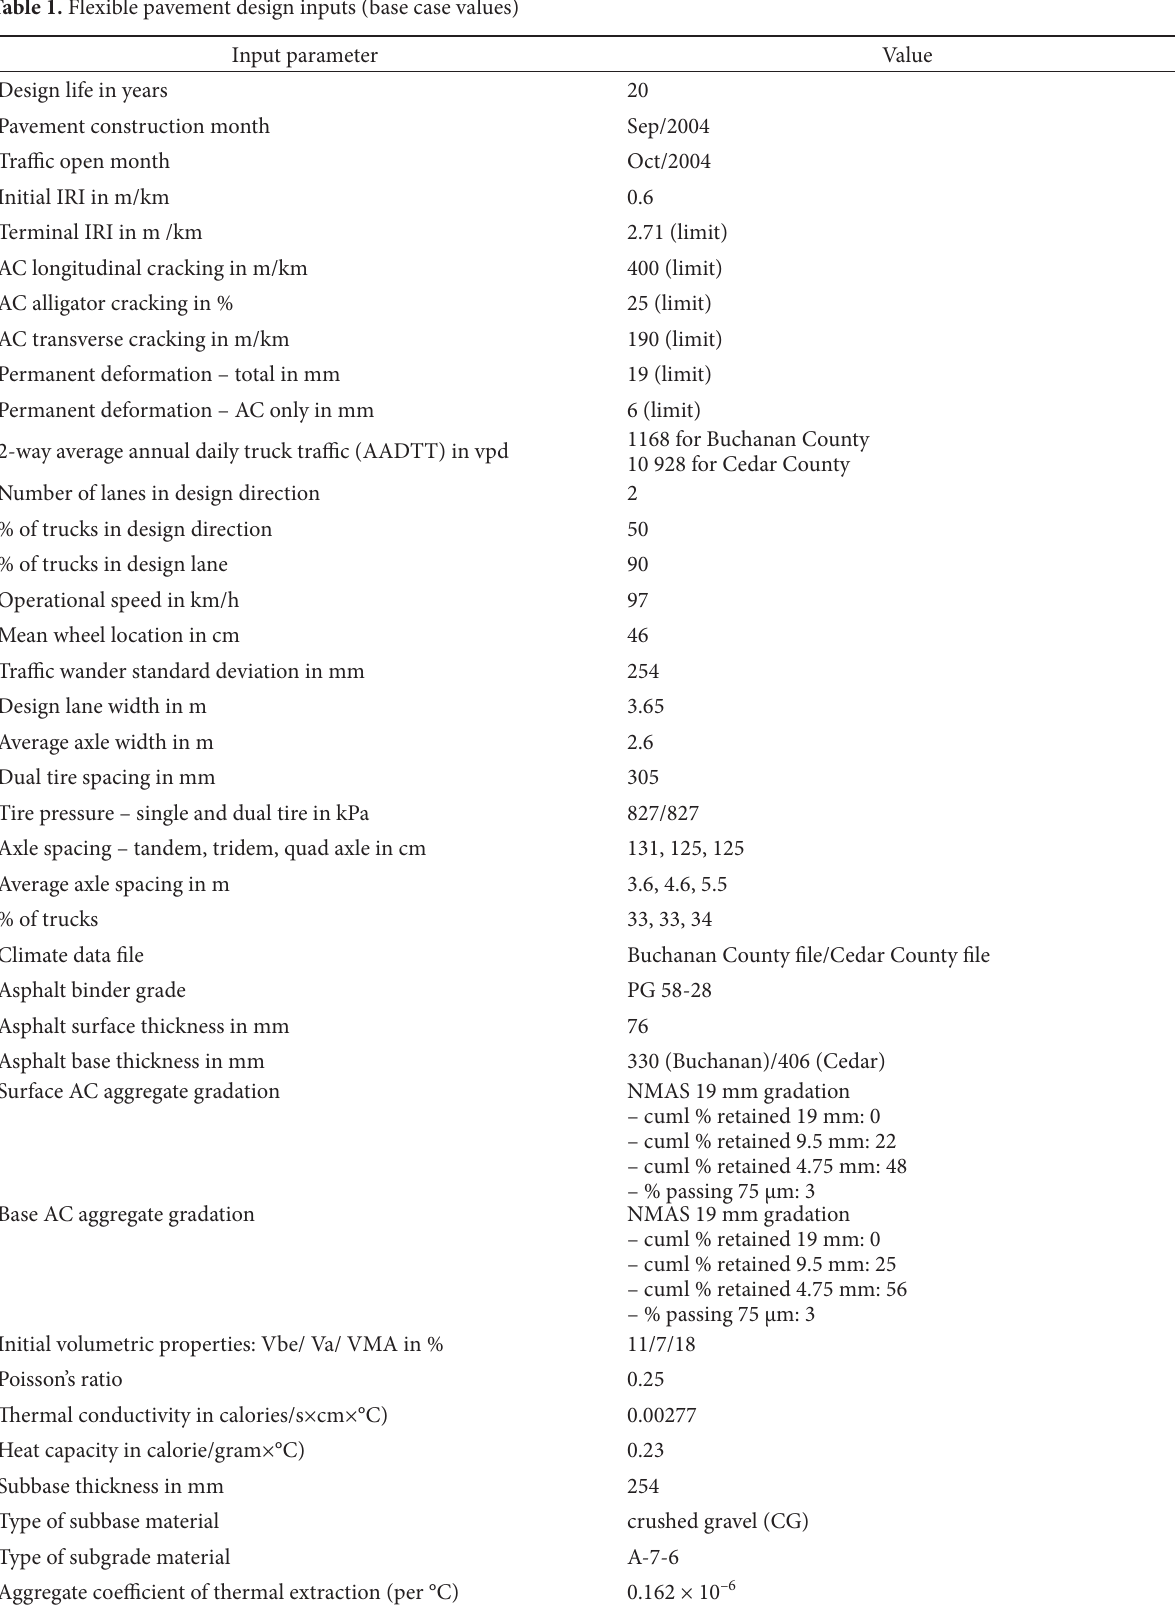
Table 1. Flexible pavement design inputs (base case